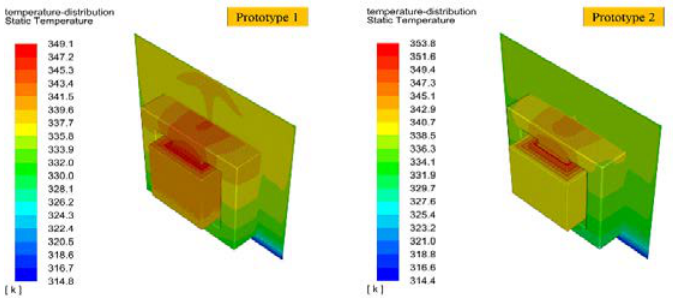
Figure 7. Temperature distribution in transformer active components and oil for the two investigated prototypes.